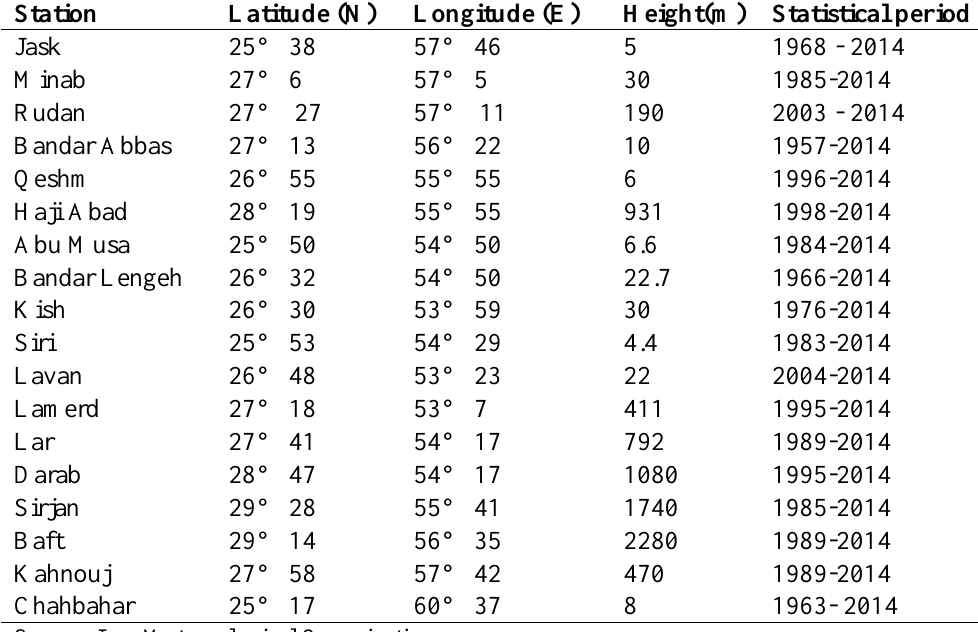
Table 1. Studied stations in Hormozgan province and adjacent station